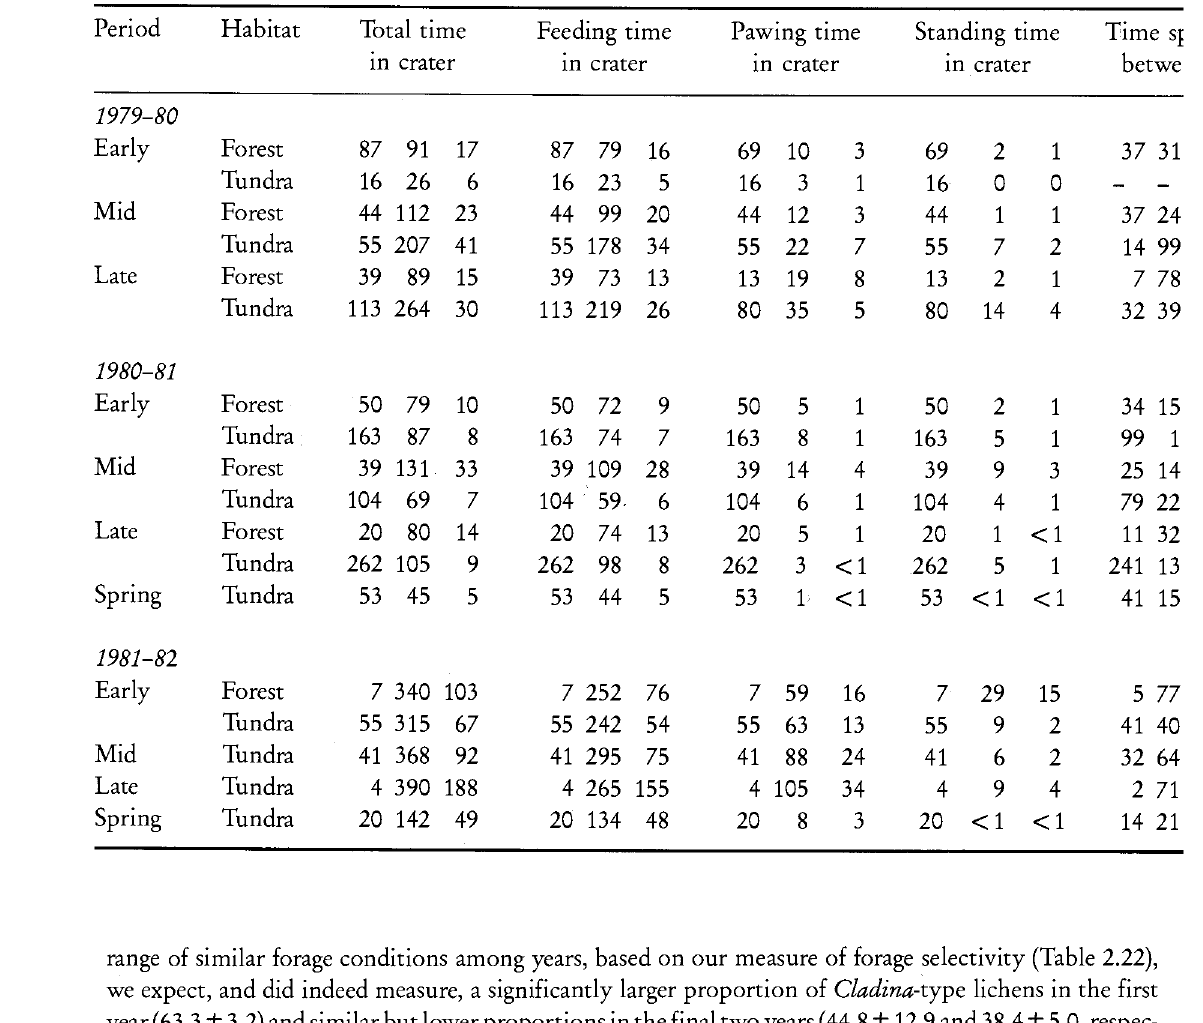
Table 2.20. Summary of entering activities (seconds) for the Porcupine Caribou Herd during the three i Period Habitat Total time Feeding time Pawing time Standing time Time sj. in crater in crater in crater in crater betwe